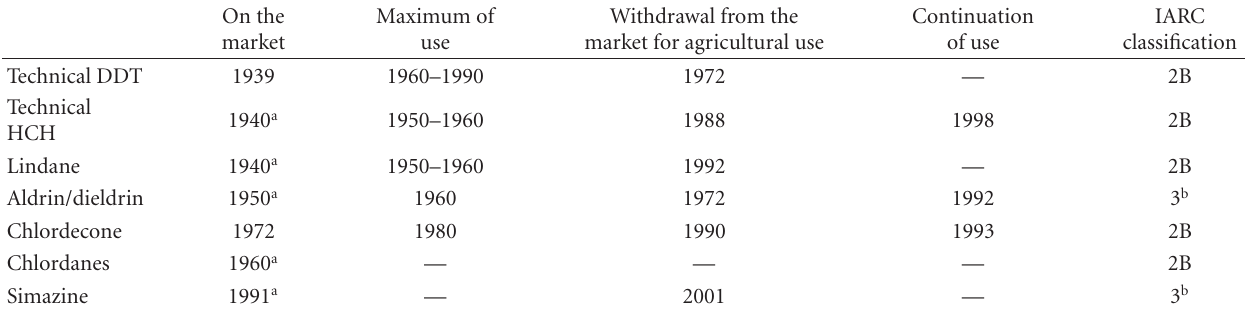
Table 3: CMR and presumed CMR pesticides used in